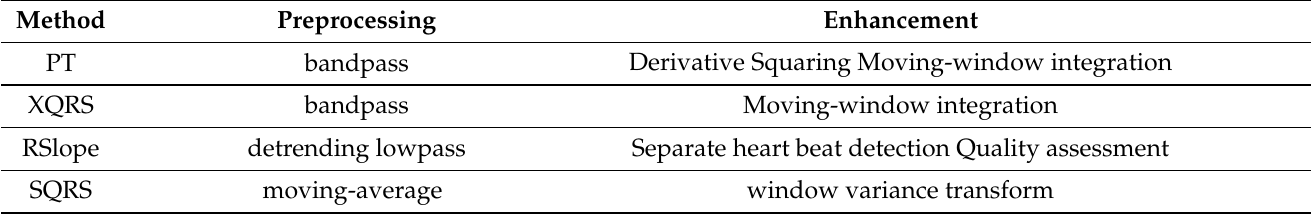
Table 4. The enhancement stages among the four methods.